Question: Give a one-sentence summary of this figure.
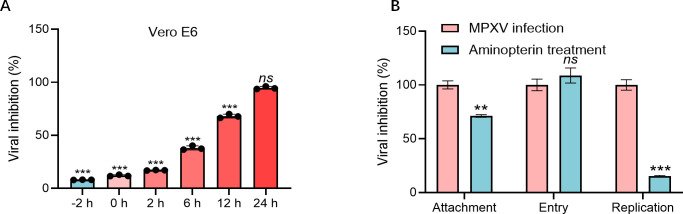
Answer: Aminopterin interrupts viral attachment and replication. ( A ) Vero E6 cells were treated with aminopterin at various time points (−2 h, 0 h, 2 h, 6 h, 12 h, and 24 h). Furthermore, Vero E6 cells were infected with MPXV (1 × 10 4 PFU) for 48 h, with viral inoculation performed at 0 h in the presence of aminopterin. Intracellular MPXV-F3L DNA content was determined by qPCR assay ( n = 3, independent experiments). ( B ) Intracellular MPXV-F3L DNA levels were determined by qPCR analysis in the attachment assay, entry assay, and replication assay ( n = 3, independent experiments). Data expressed as means of technical replicates ± SD and Student’s t -test ( A and B ) were performed in this section (** P < 0.01, and *** P < 0.001, ns: not significant).